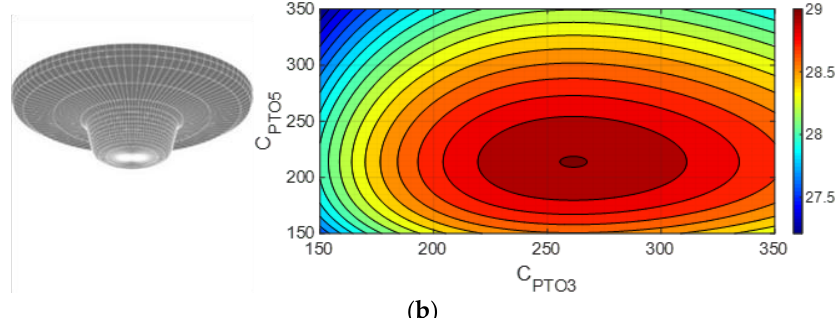
Figure 8. Isoperformance curves of ( a ) Cylindrical WEC and ( b ) Nailhead-shaped WEC over flat bottom.